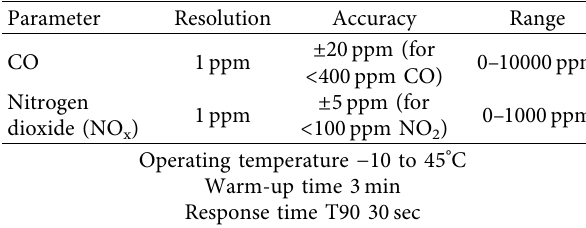
Table 2: Uncertainty error analysis.